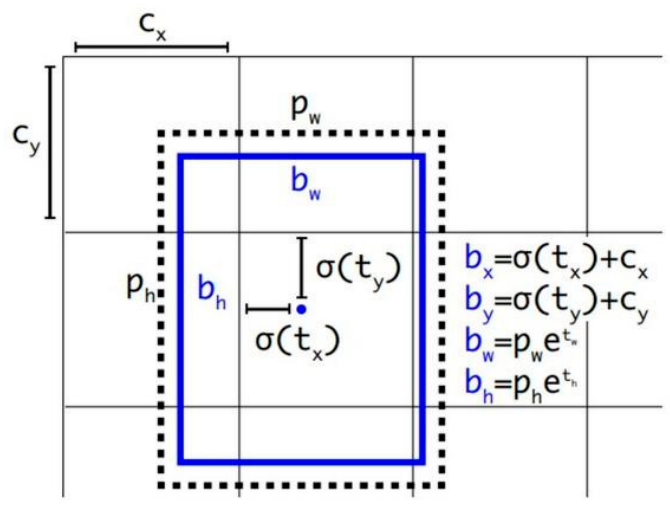
Figure 9. Goal box regression schematic .